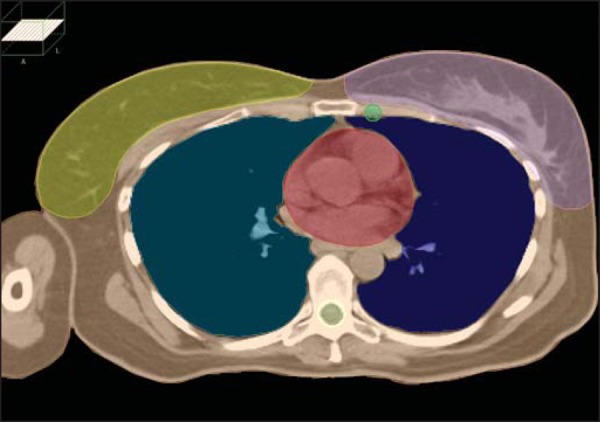
Volumes (lungs, heart, spinal cord, contralateral breast, clinical
target, and internal mammary lymph nodes) contoured in accordance with
RTOG Breast Cancer Atlas for Radiation Therapy Planning: Consensus
Definitions.